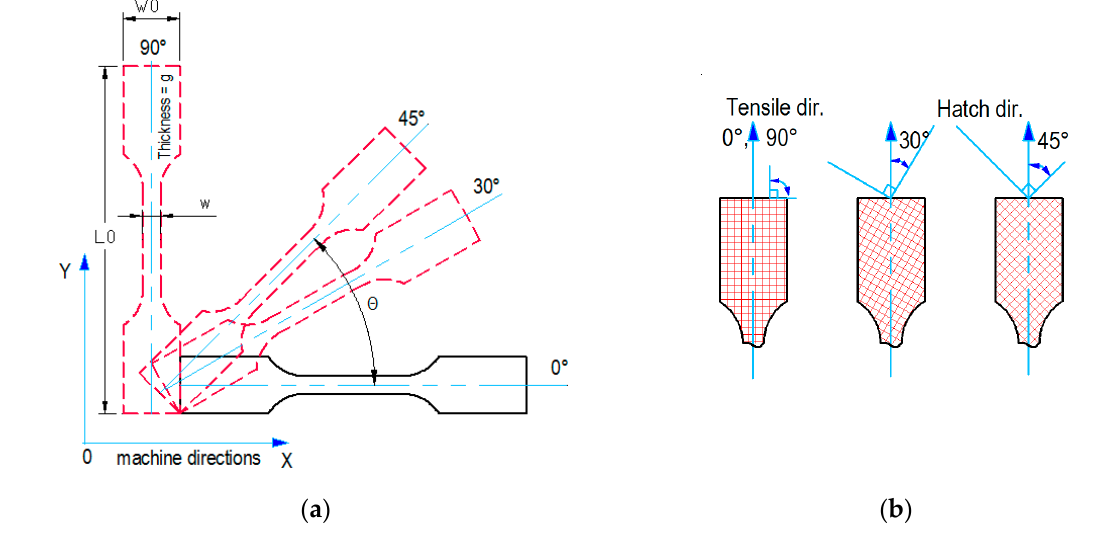
Figure 4. Test sample model. ( a ) orientation of the sample inside the building envelope; ( b ) hatching lines according to the longitudinal axis (tensile direction) of the sample.